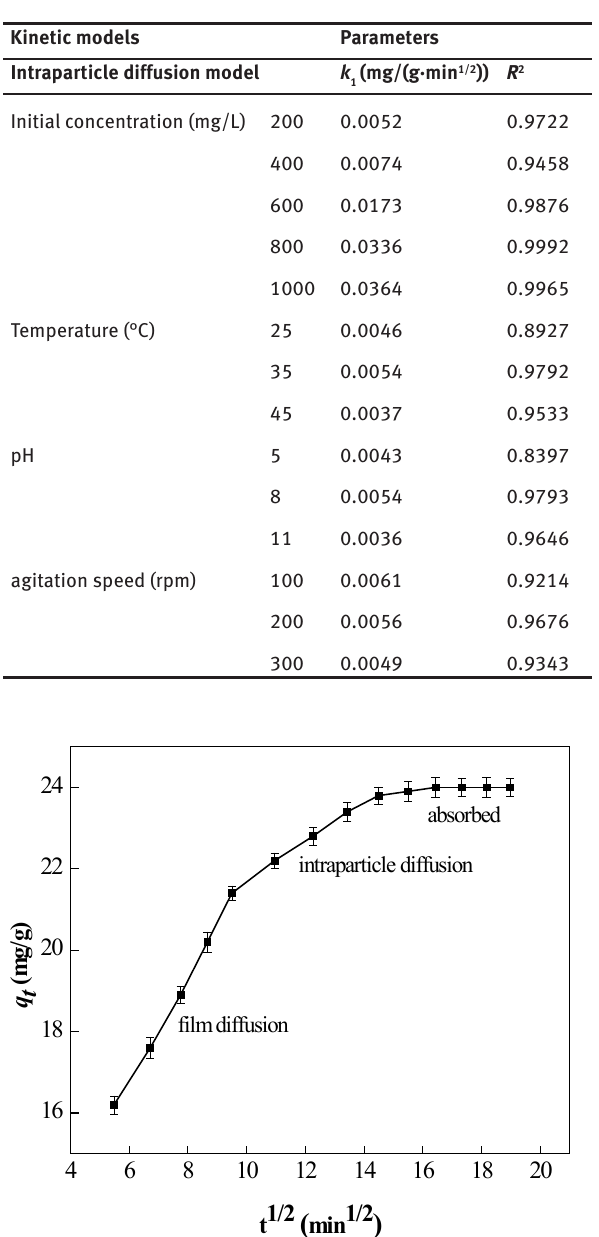
Table 3: Kinetic parameters of pseudo-first- and second-order models.